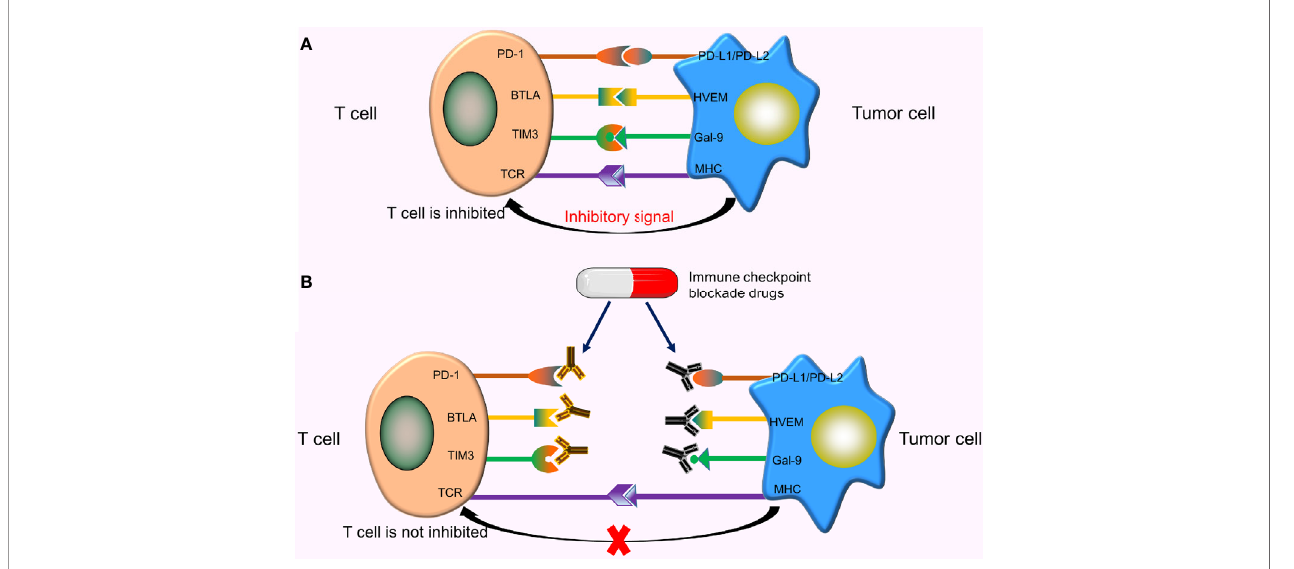
FIGURE 4 | Immune checkpoints and immune checkpoint inhibitors. (A) When these immune checkpoints bind to the corresponding ligands, inhibitory signals transmitted from tumor cells inhibit T cell activation; (B) These immune checkpoint inhibitors speci fi cally bind to the corresponding checkpoints on the T-cell surface or tumor cell surface, thereby blocking the binding of these checkpoints to corresponding ligands, ultimately preventing the transmission of inhibitory signals from tumor cells to T